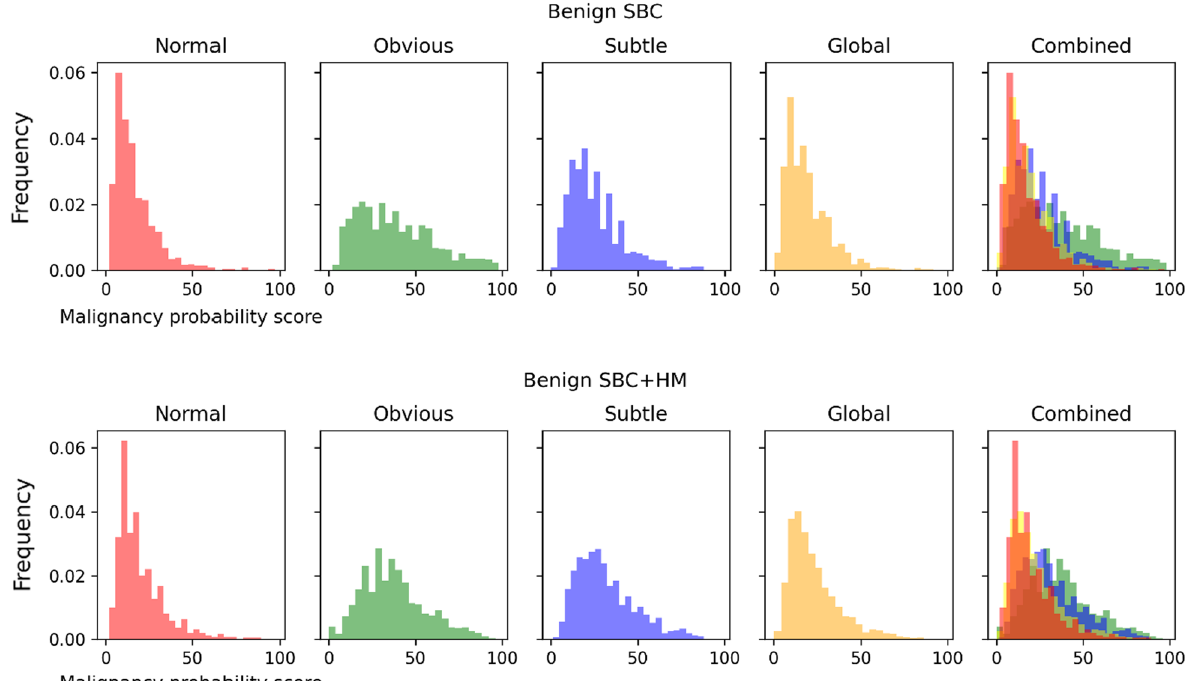
Fig. 10 Distribution of single breast classifier (SBC) and SBC mammograms split into 25 bins for each of the image type categories, with a combined plot showing the overlap between normal (red), obvious (green), subtle (blue), and global (yellow)